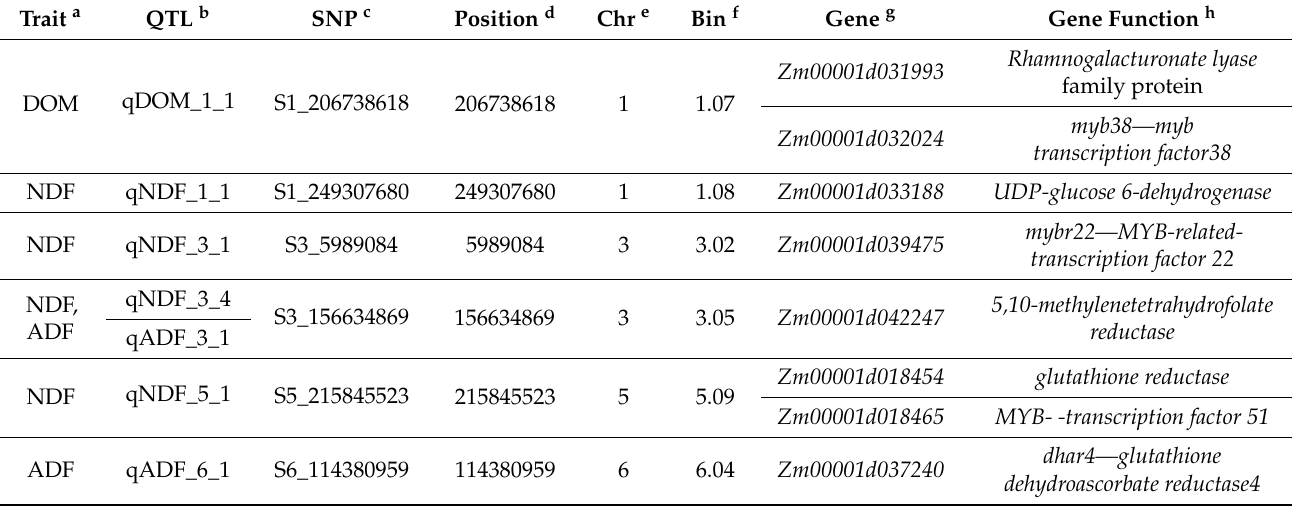
Table 5. Candidates genes and enzymes proposed for forage digestibility and fiber contents in the maize MAGIC population. Trait